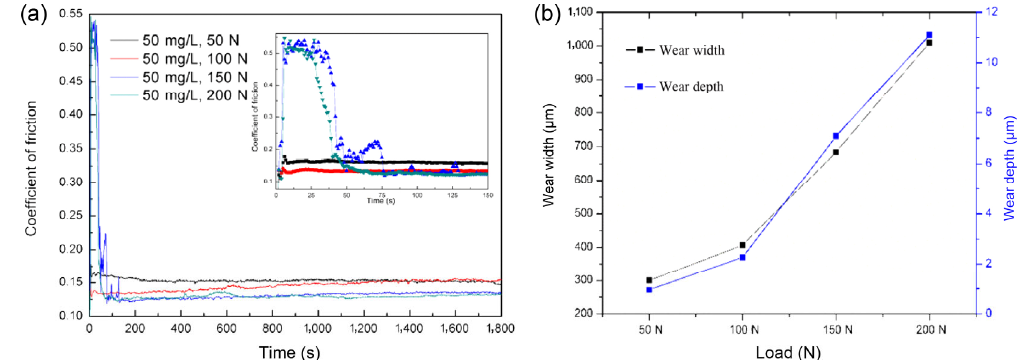
Fig. 18 Friction properties of MoS 2 -16C at various loads: (a) COF of MoS 2 -16C at various loads; (b) wear width and wear height of lower samples